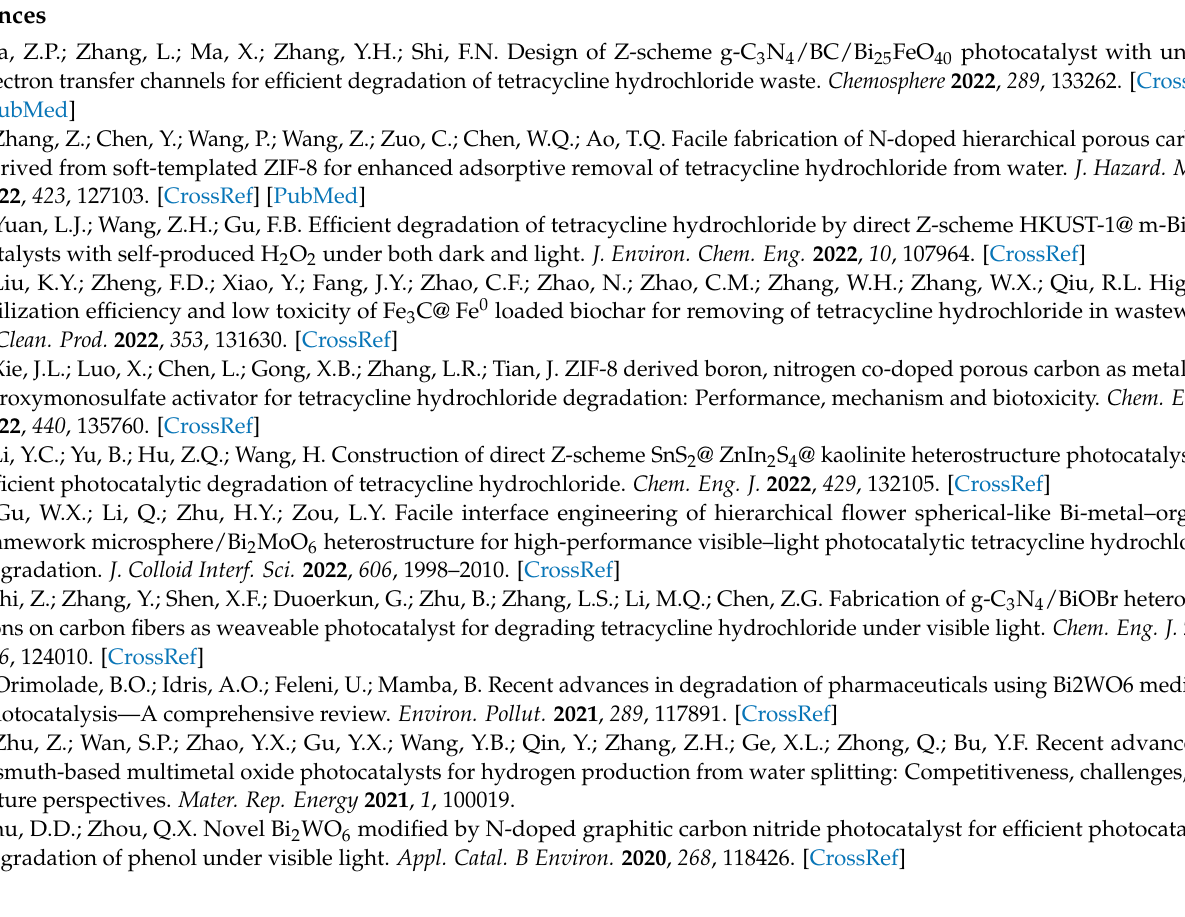
Table S2. Atomic percentage of different elements present in 30%PCNS/BWO samples. Table S3. Comparison with other BWO-based photocatalysts for the degradation of TC-HCl [31,38,62–70].